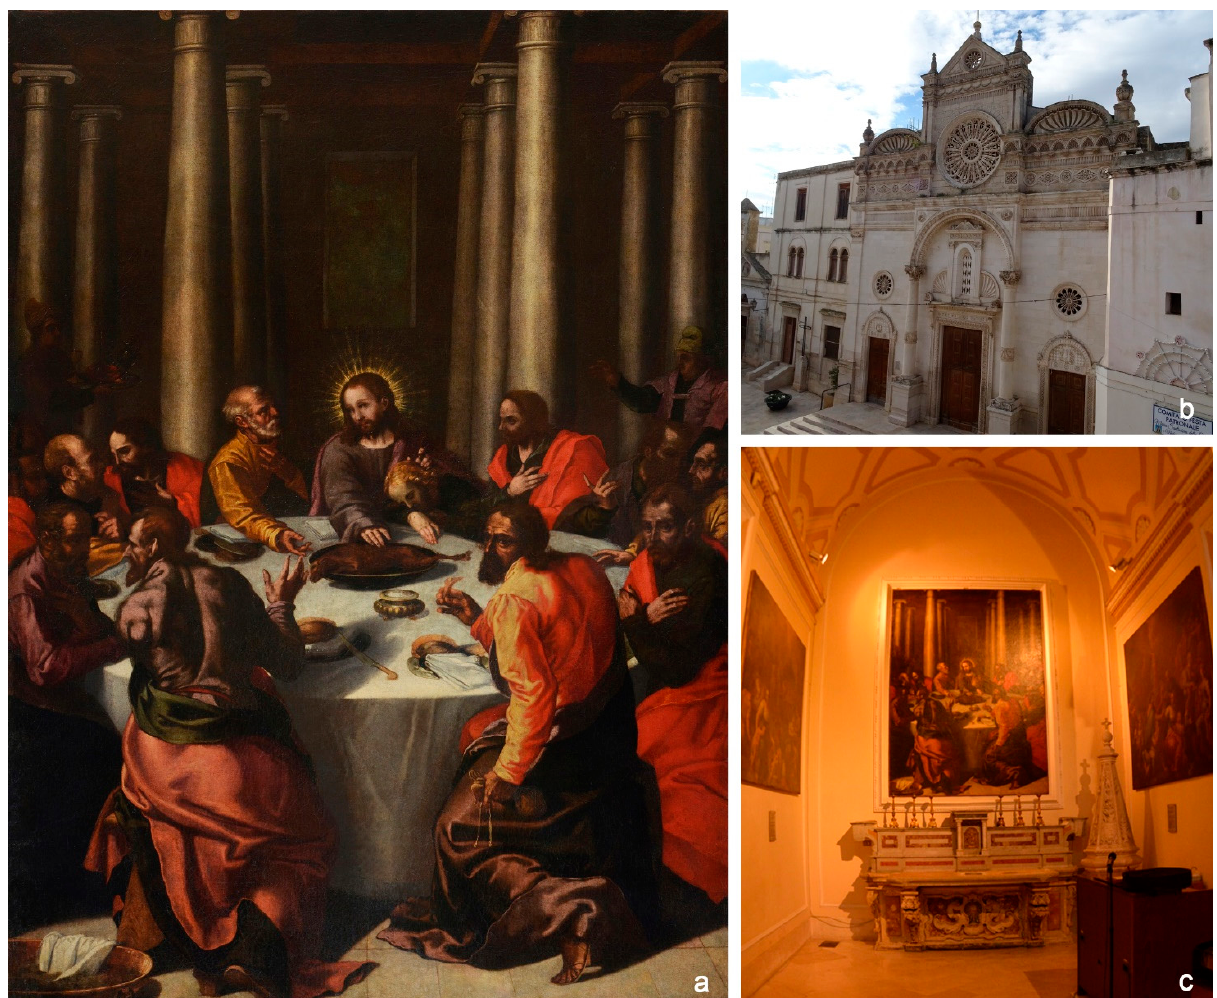
Figure 1. ( a ) Gaspar Hovic, “Last Supper”, 1583–1593(?); ( b ) facade of the church of St. Maria Veterana; ( c ) Chapel of the Blessed Sacrament of the St. Maria Veterana